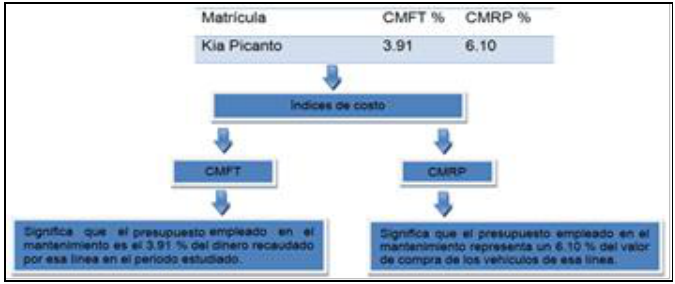
Figura 3. Indicadores de